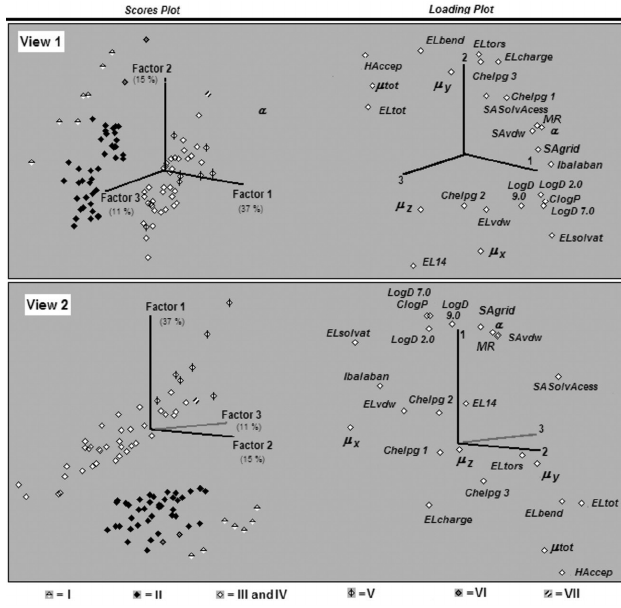
FIGURE 6 - Scores and loadings on 3D plots found for the first three factors or